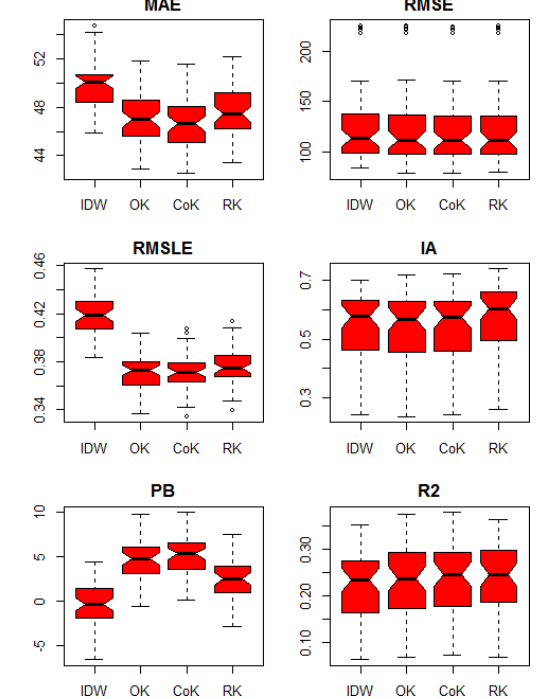
Figure 8. Box plot of the 5 × 10-fold cross-validation